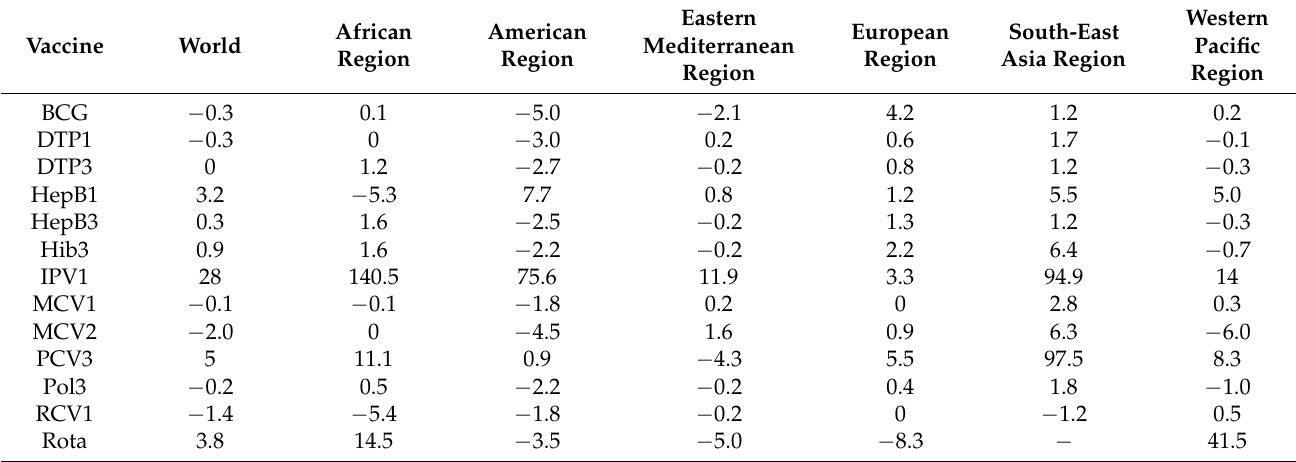
Table 3. Variation (%) from 2015 to 2019 for the mean percentages of routine vaccination coverage in different regions of the World Health